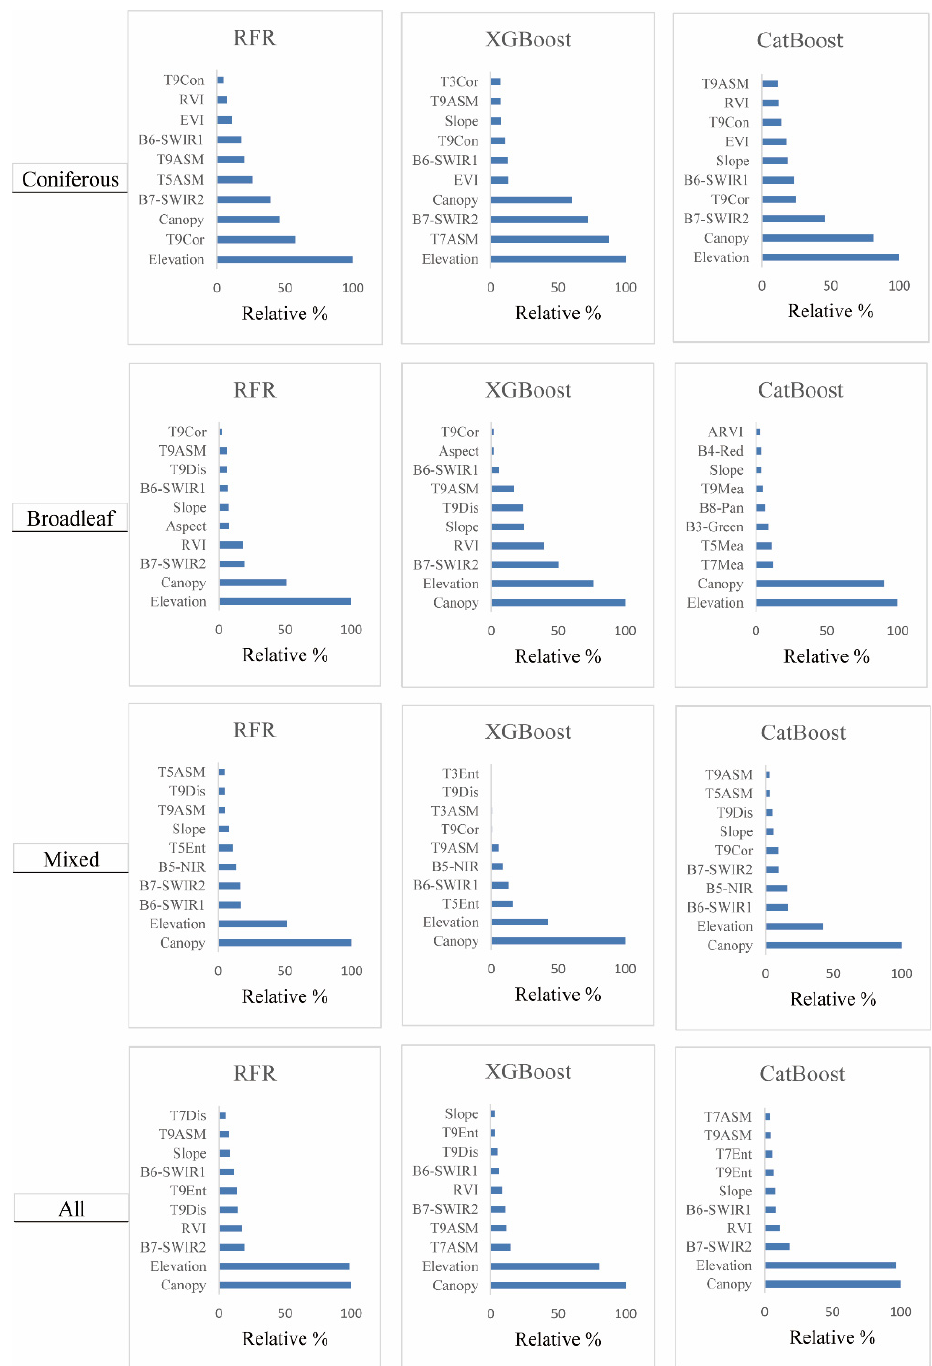
Figure A1. Variable importance ranking for the different forest types by combining feature selection method (LASSO) and three machine learning algorithms (RFR, XGBoost, and CatBoost).